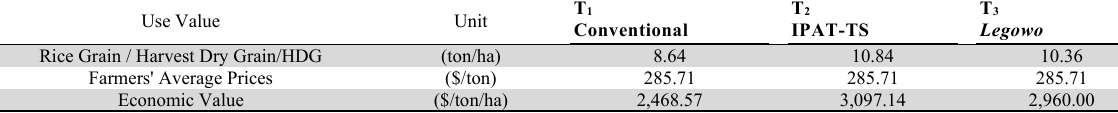
The Rice Grain Price and Economic Valuation of Cultivation Technology Use